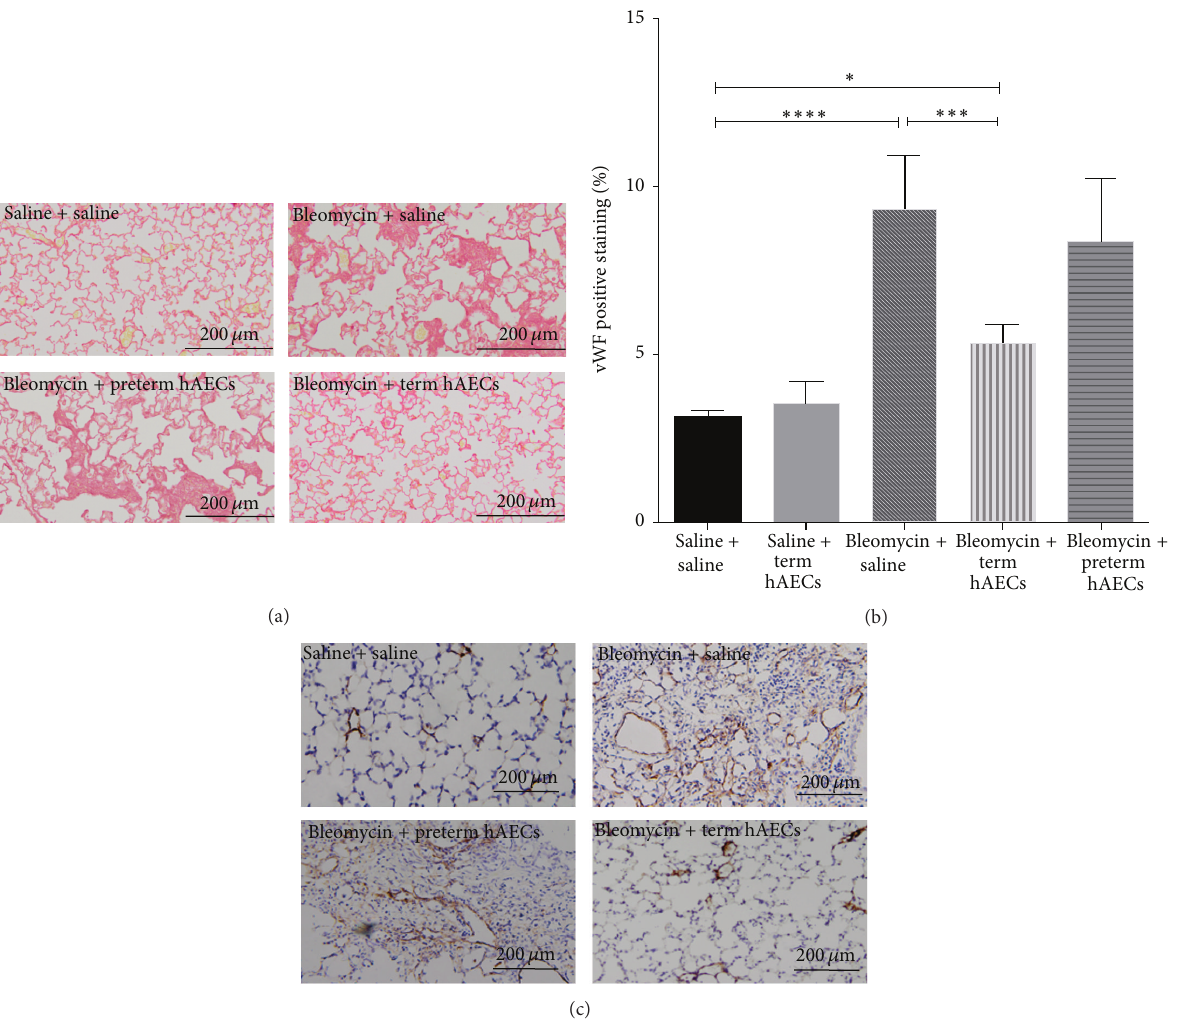
Figure 6: Collagen staining and vWF immunohistochemistry in bleomycin challenged mouse lung tissue. (a) Bleomycin challenged mice had more fibrotic tissues in the lung compared to control group; term hAEC treatment, but not preterm hAEC treatment, reduced the fibrotic tissues. (b) The percentage of vWF positive staining increased in bleomycin-injured animals compared to control group ( 𝑝 < 0.0001 ) and decreased after term ( 𝑝 < 0.001 ) but not preterm hAEC administration. (c) The representative images for vWF immunohistochemistry in mouse lung tissues ( ∗ 𝑝 < 0.05 , ∗∗∗ 𝑝 < 0.001 , and ∗∗∗∗ 𝑝 < 0.0001